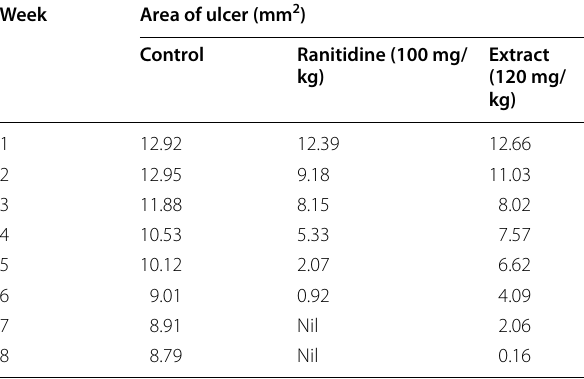
Table 5 Effect of ranitidine and C. zeylanica extract on area of ulcer in histamine-induced acute ulcers Week Area of ulcer (mm 2 )